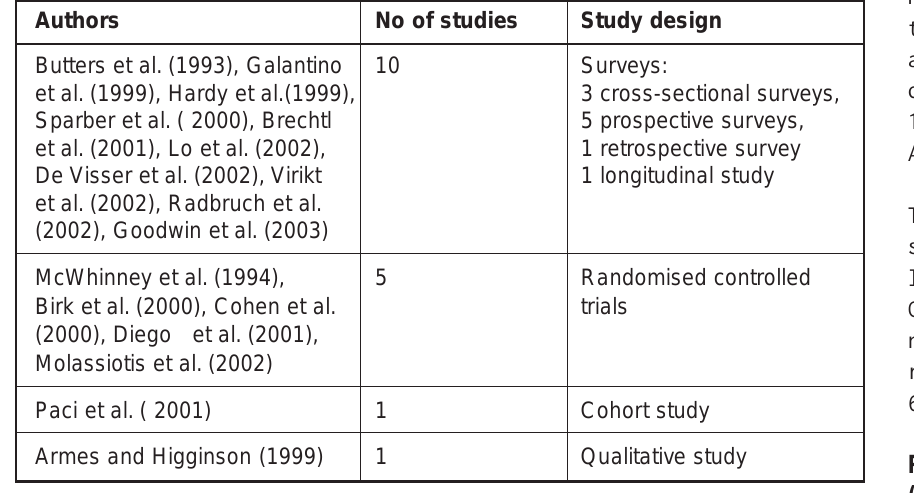
Table 3:Types of study